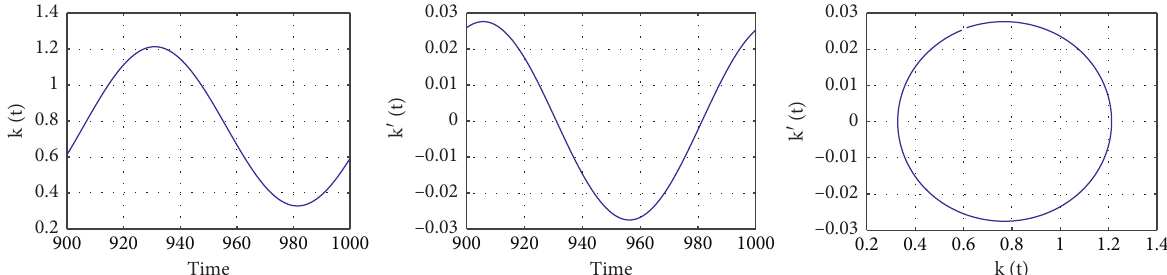
Figure 3: The birth of Hopf-bifurcated limit cycle from the fixed point k ∗ for the studied case when q � 0 .